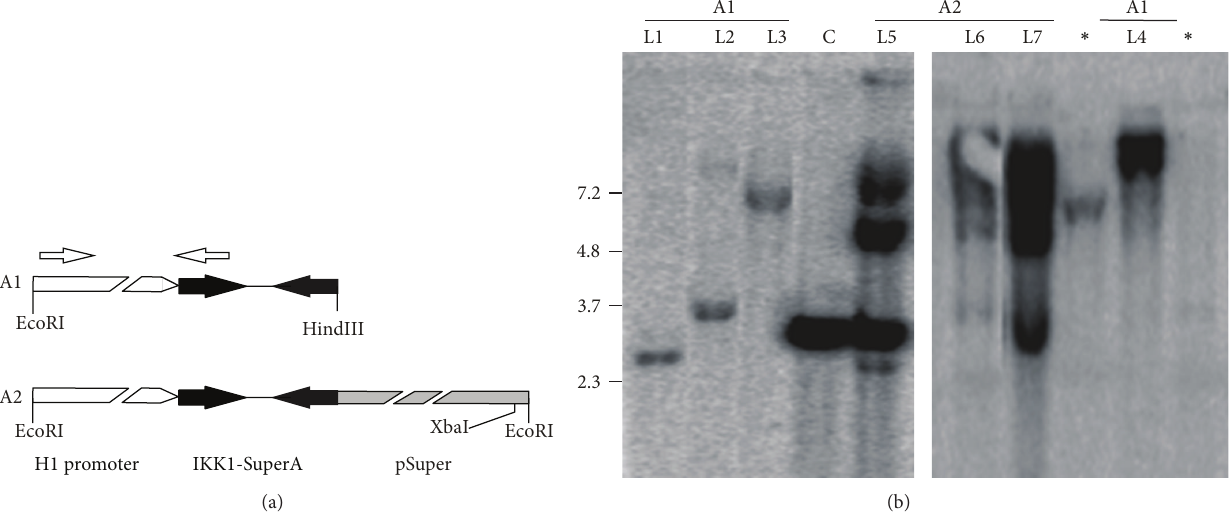
Figure 2: Generation of H1-IKK1-siRNA transgenic mice. (a) Schematic representation of the transgenes microinjected in one-cell mouse embryos. Transgene A1 is a 285 bp fragment containing the H1 promoter (white box) and the DNA oligonucleotide for shRNA synthesis (filled in black). Transgene A2 contained, in addition, the rest of the pSuper plasmid in its 3 󸀠 end (3234 bp total length). White arrows indicate the primers used for PCR-genotyping of transgenic mice. Relevant restriction sites are indicated. (b) Southern blot analysis of transgenic founders. The transgene injected (A1 or A2) and the name of the transgenic lines (L1 to L7) are indicated. Asterisks indicate founder mice that did not transmit the transgene to their progeny and were not included in further analysis. In the lane marked as C it was loaded DNA from a nontransgenic control mouse and the amount of fragment A2 corresponding to 20 copies per haploid genome. Figures in the left of the blot indicate fragment size in